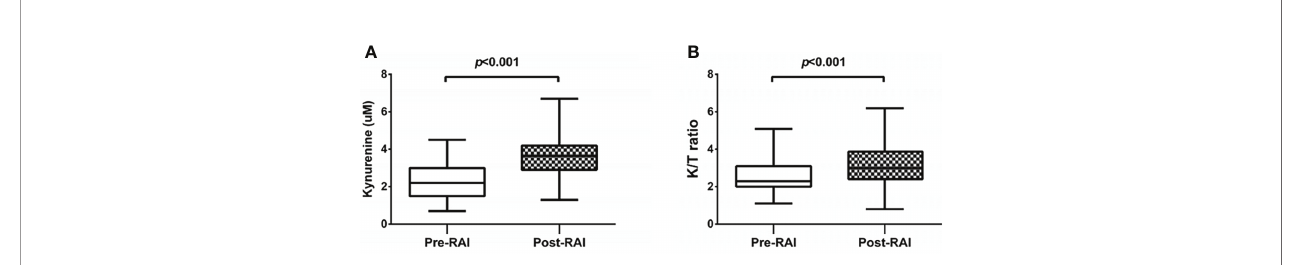
FIGURE 1 | Changes of kynurenine concentrations (A) and the K/T ratios [Kynurenine ( m M)/Tryptophan( m M) x 10 2 ] (B) in serum samples at pre-RAI and post-RAI time points.